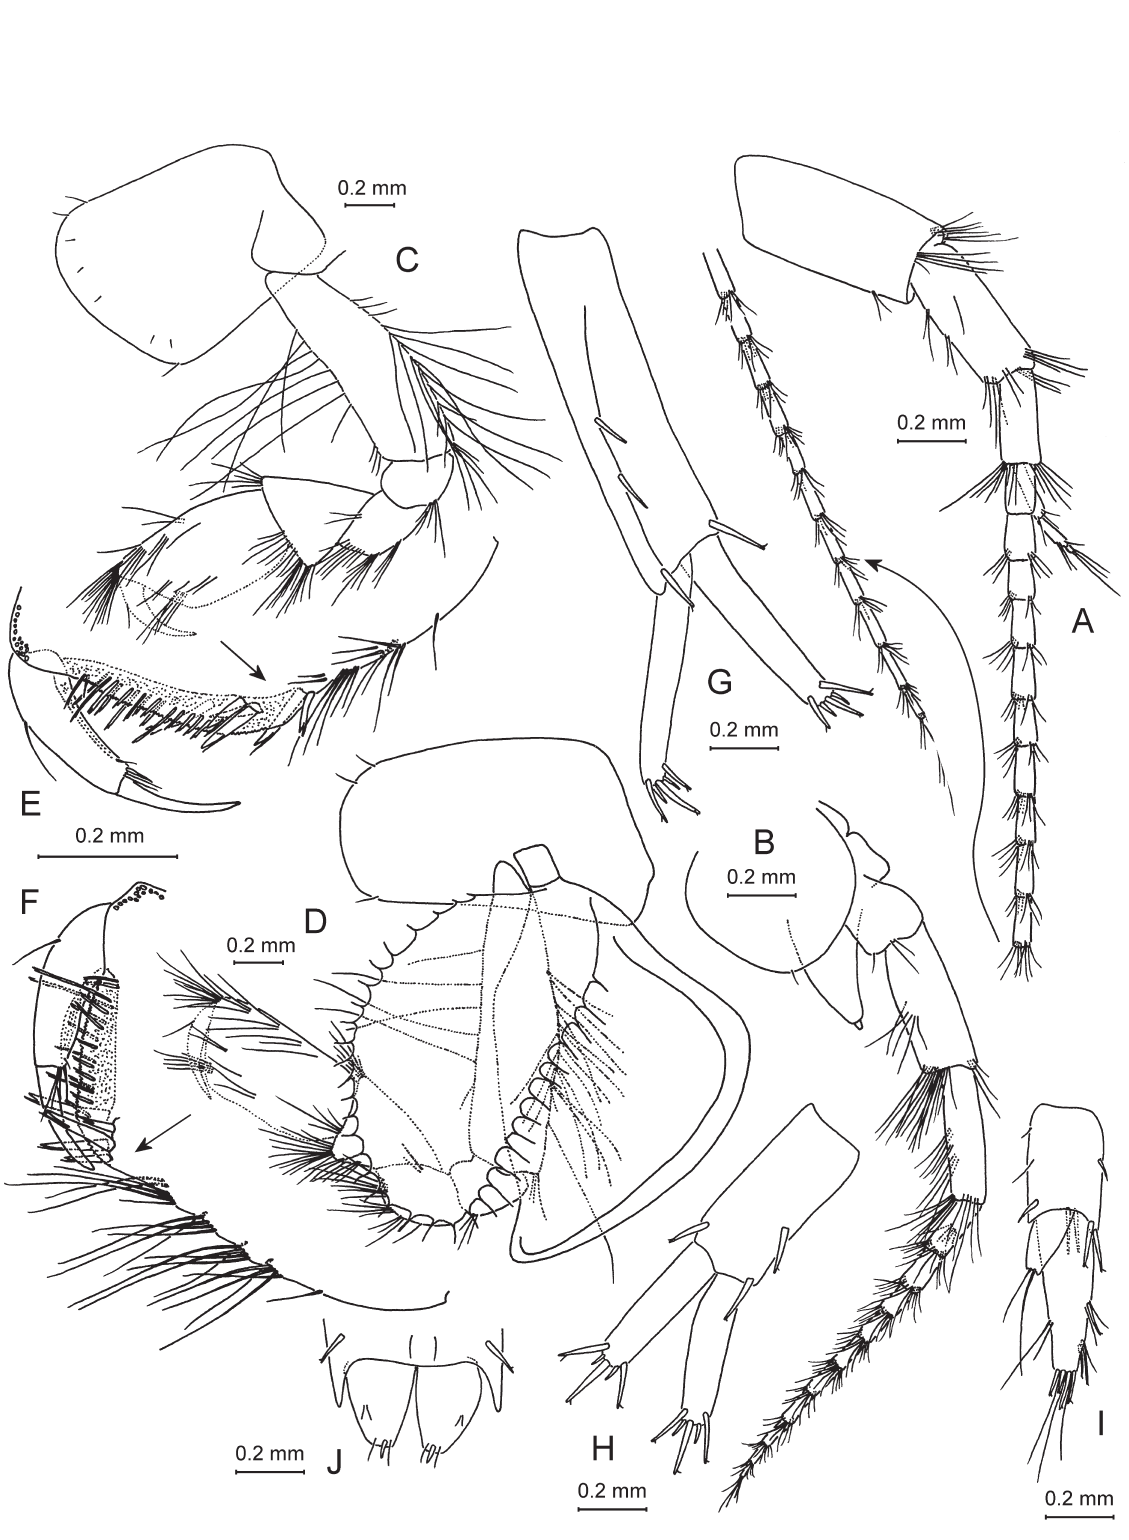
Fig. 11. Zenkevitchia sandroruffoi sp. nov. Paratype, ♀, 8.3 mm, X44043/Cr-1649-FEFU. A . Antenna 1. B . Antenna 2. C . Gnathopod 1. D . Gnathopod 2. E–F . Palmar margins of gnathopods 1 and 2 propodi. G . Uropod 1. H . Uropod 2. I . Uropod 3. J .